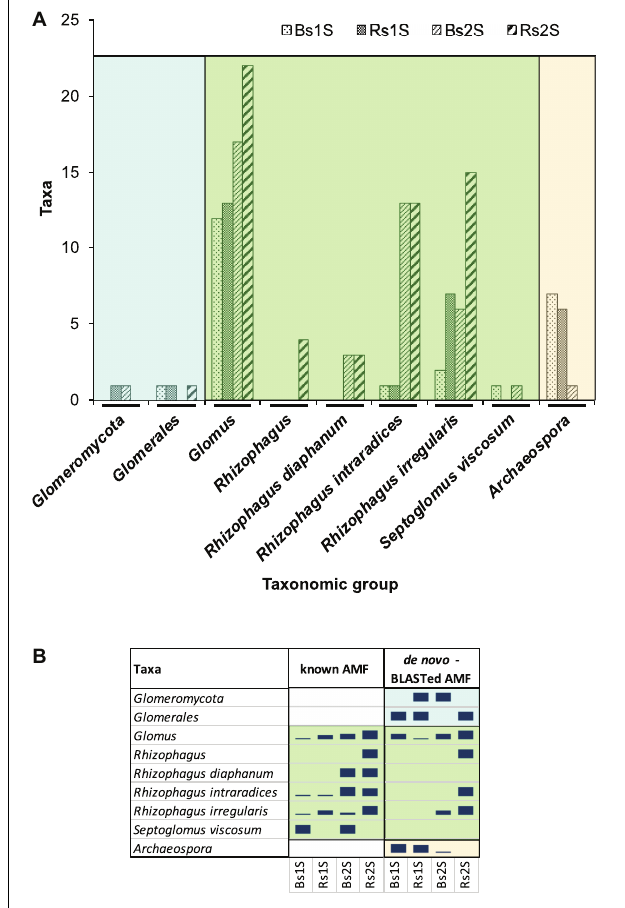
FIGURE 8 | (A) Number of taxa belonging to the different taxonomic groups – obtained by adding the “ de novo -BLASTed AMF” taxa with the “known AMF” ones on the basis of the group to which they belonged – in the different samples (Bs = soil not associated to grapevine roots, Rs = soil associated with the roots of Vitis vinifera cv. Pinot Noir) at the two sampling times (1S = flowering and 2S = fruit development). (B) Relative abundance of taxa obtained considering separately “known AMF” and “ de novo -BLASTed AMF”, belonging to each taxonomic group, in Bs and Rs soils at the two sampling times (1S = flowering and 2S = fruit